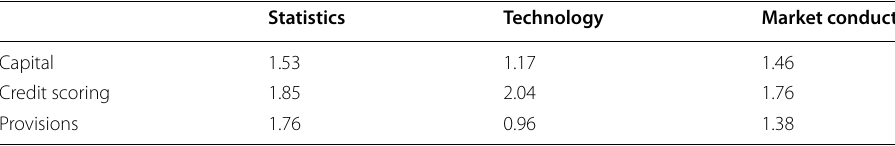
Table 9 Average number of negative terms in the 20 words surrounding the key terms